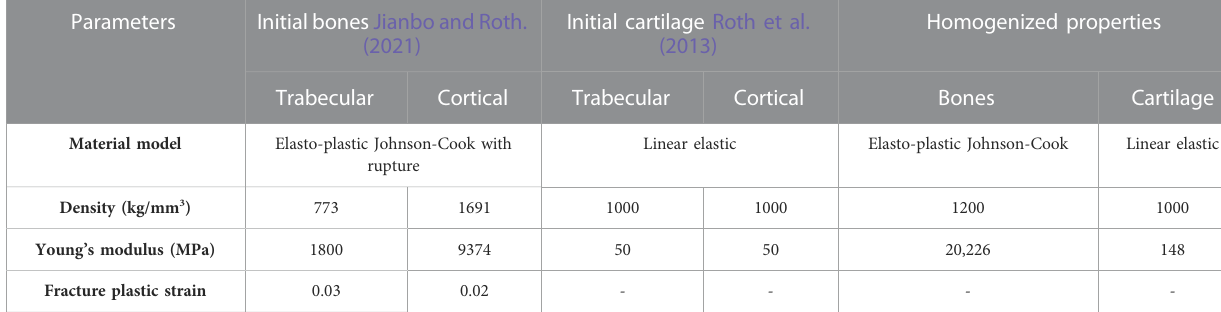
TABLE 1 Initial and new bone and costal cartilage